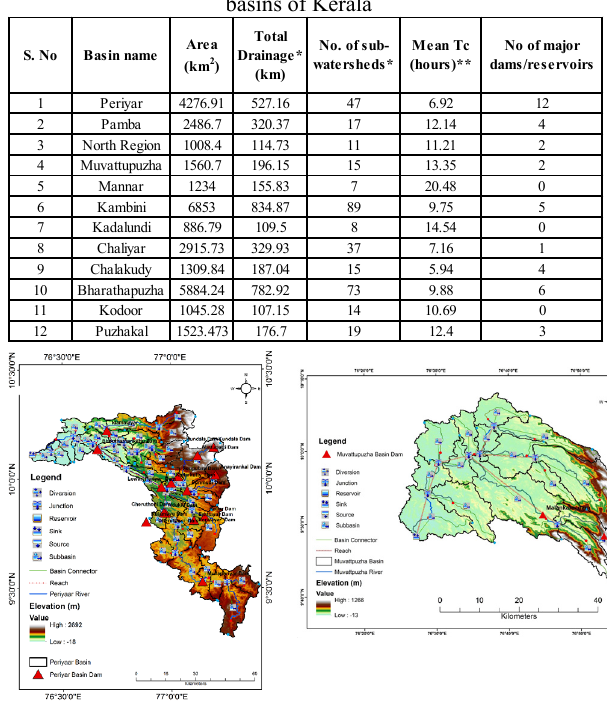
Figure 5. HMS model setup of a) Periyar River and b) Muvattupuzha River basins derived from HEC-GeoHMS.